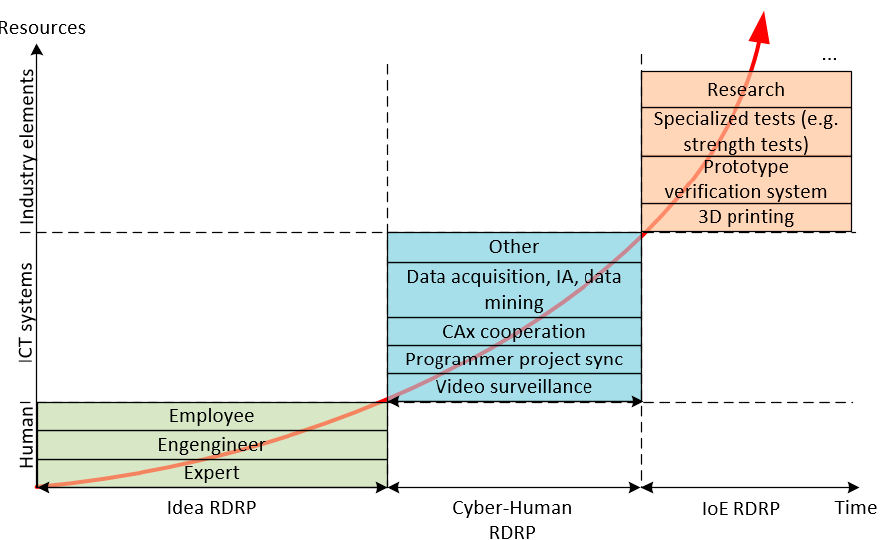
Figure 1. The evolution process of RDRP systems.